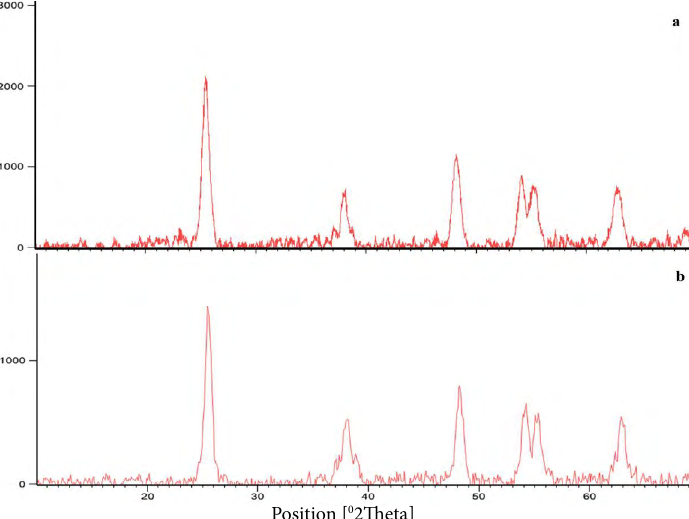
Fig. 1. XRD pattern of prepared samples: (a) TiO2; (b)